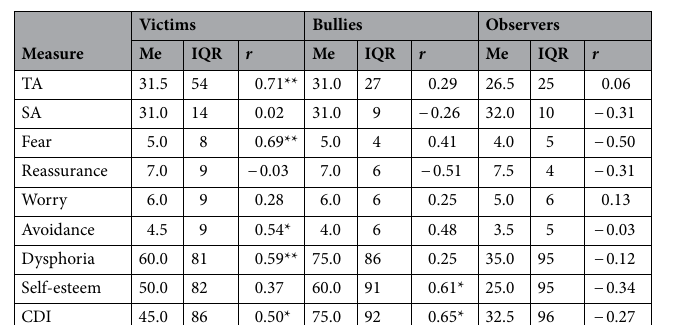
Victims Measure